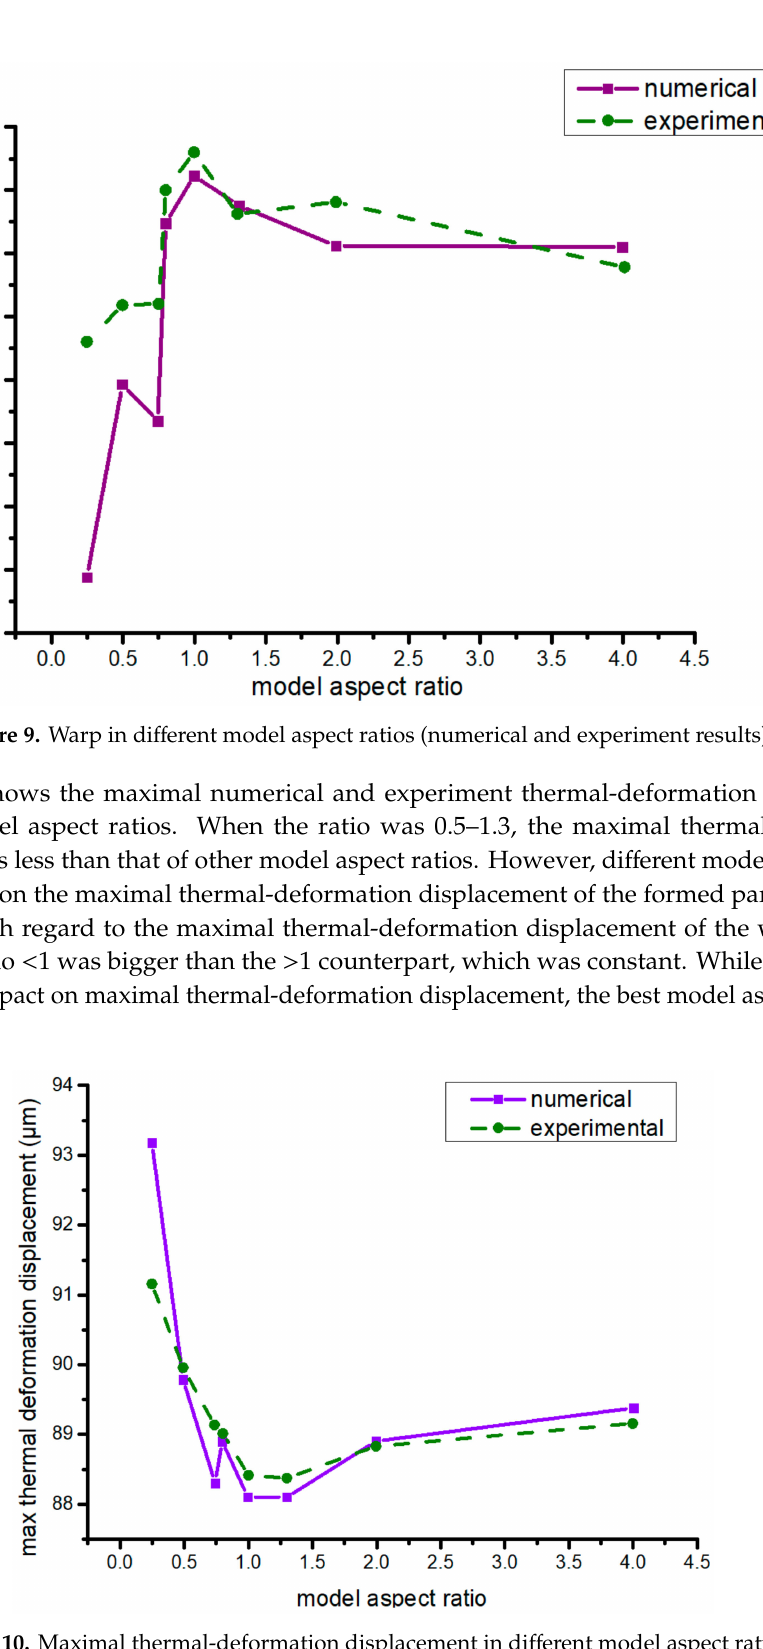
Figure 10. Maximal thermal-deformation displacement in di ff erent model aspect